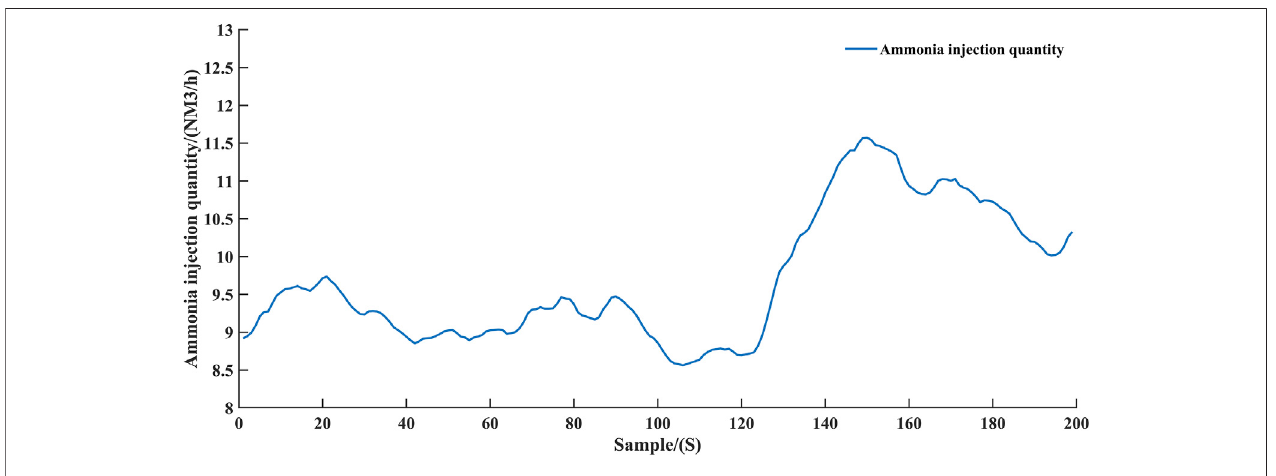
FIGURE 9 | Ammonia injection amount given by agent controller.